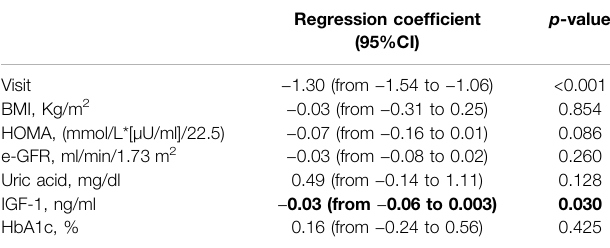
TABLE 6 | Multivariate linear mixed models of GLS over time.